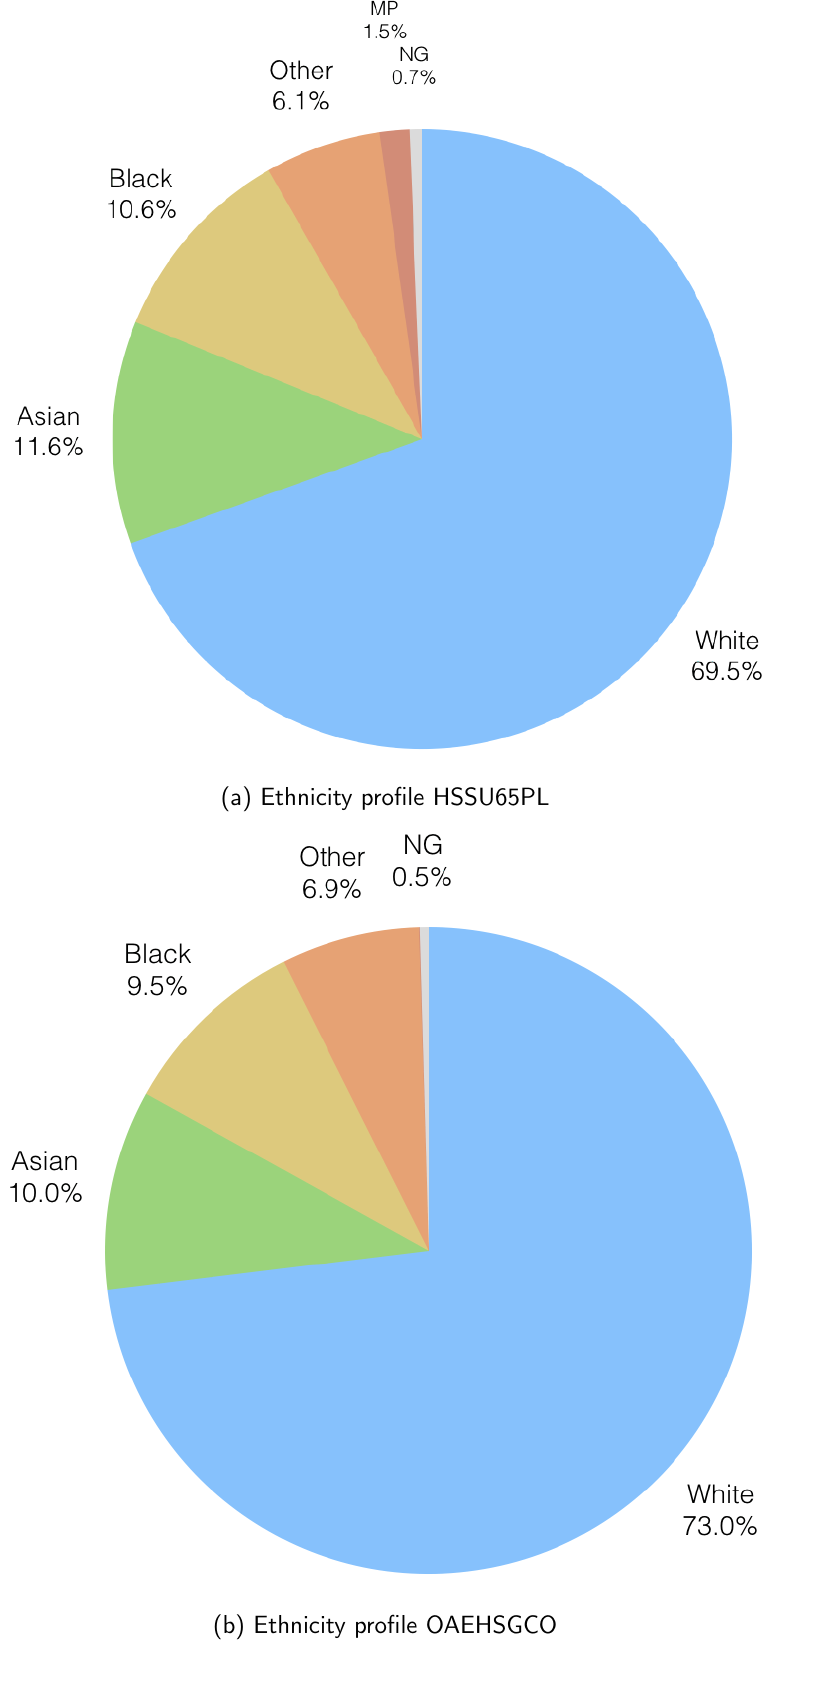
Figure 8: Ethnicity profile of the recipients of OAEHSGCO and